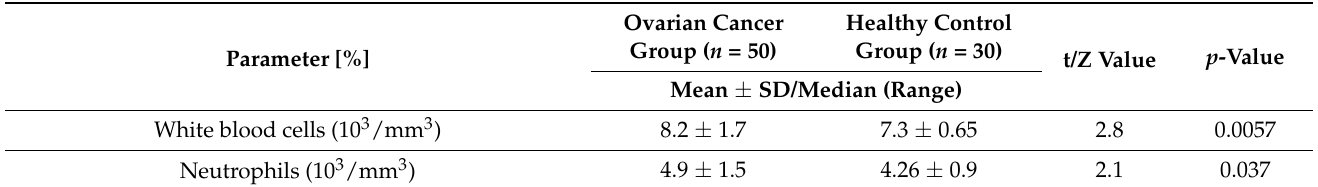
Table 2. Dendritic cell, monocyte and basic peripheral blood lymphocyte subset counts, as well as the frequencies of these cell subsets expressing the TLR2 antigen in the study and control